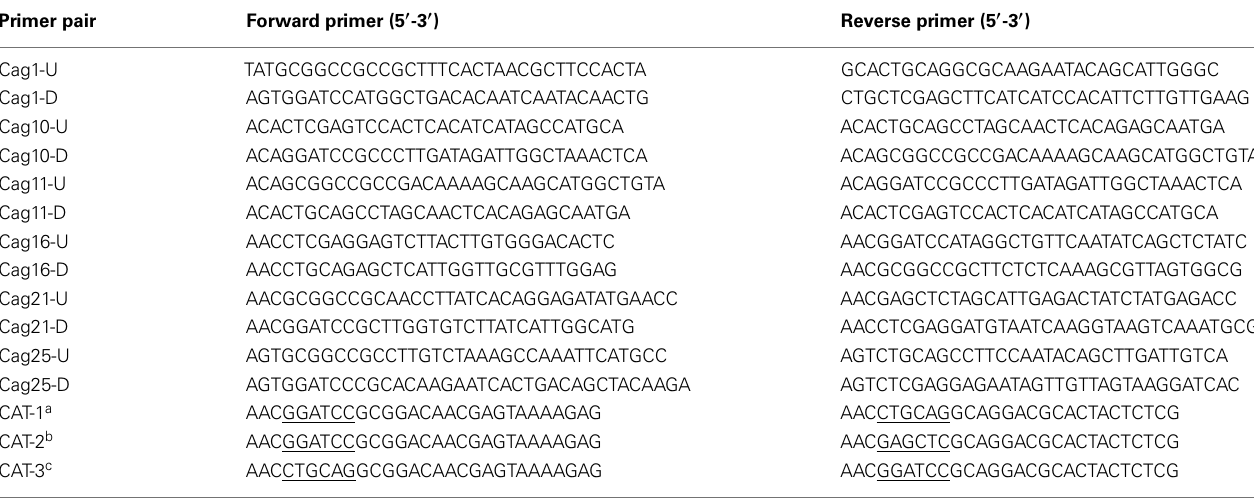
TableA3 | Primer pairs used to construct promoter knockouts. Primer pair